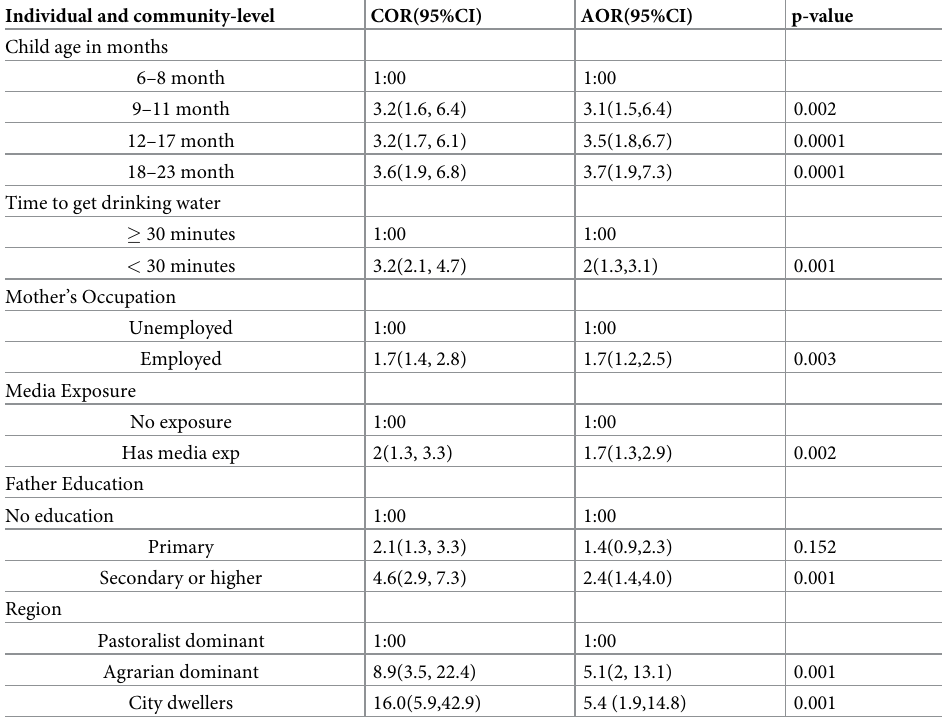
Table 5. Individual and community level factors affecting feeding according to minimum acceptable diet for 6–23 months age children in Ethiopia, 2016(n = 2919). Individual and